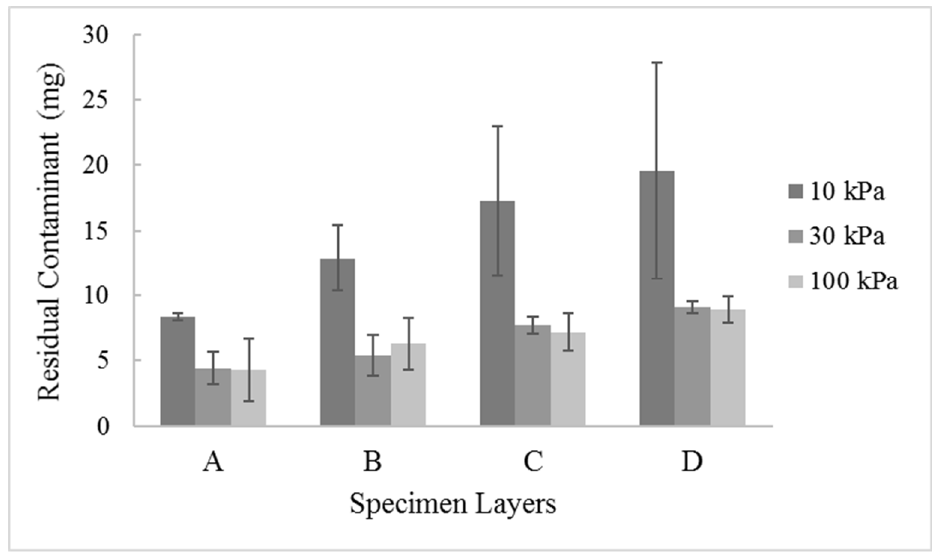
Figure 2. Chromium (VI) residual value in different soil layers.